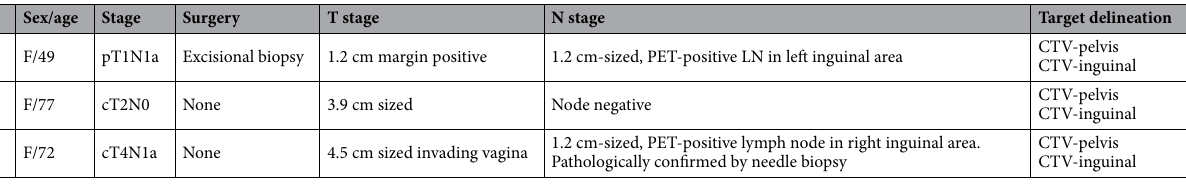
Table 1. Patient